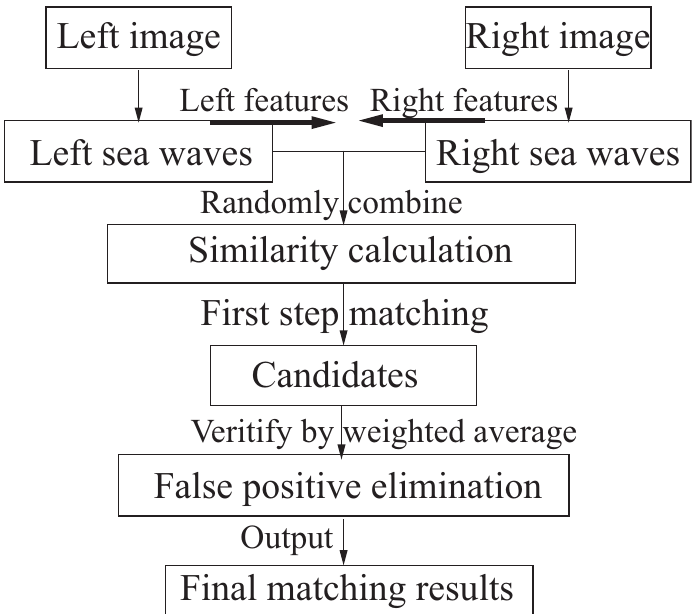
Figure 9. The whole work flow chart of our proposed matching